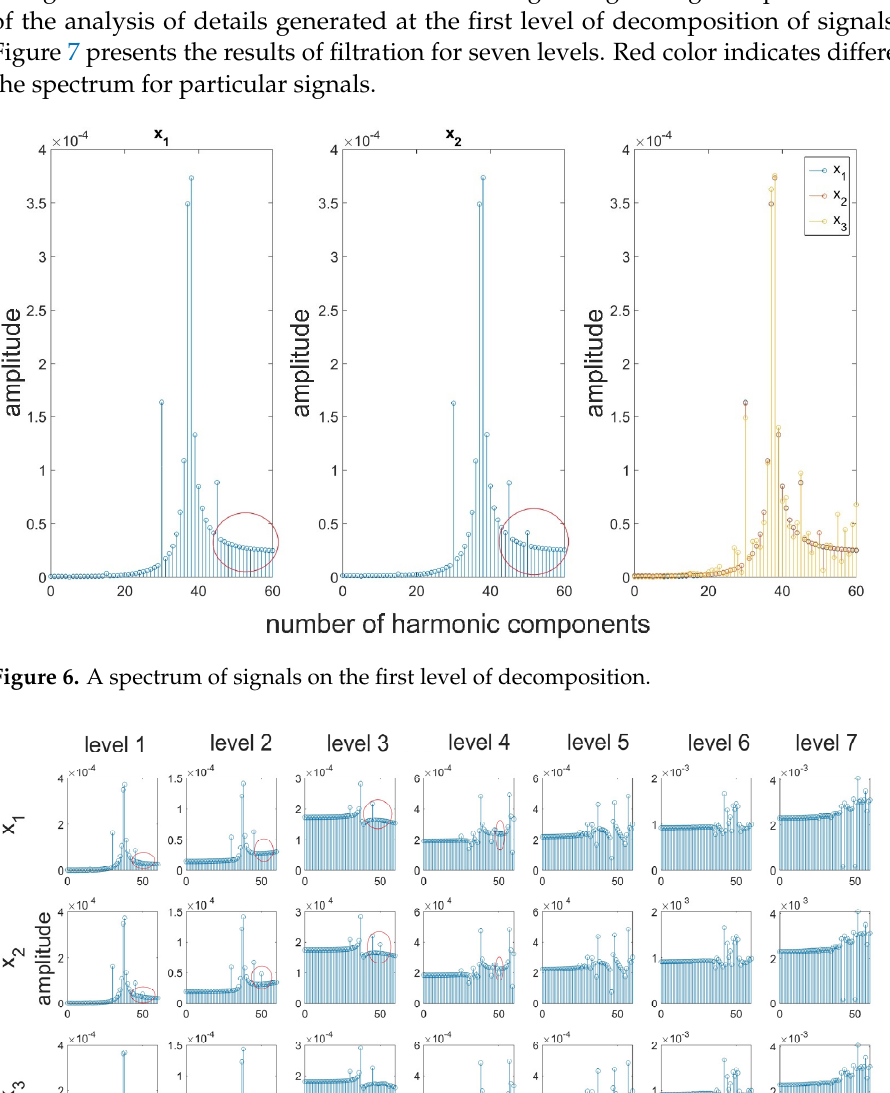
Figure 5. Amplitude spectral density.